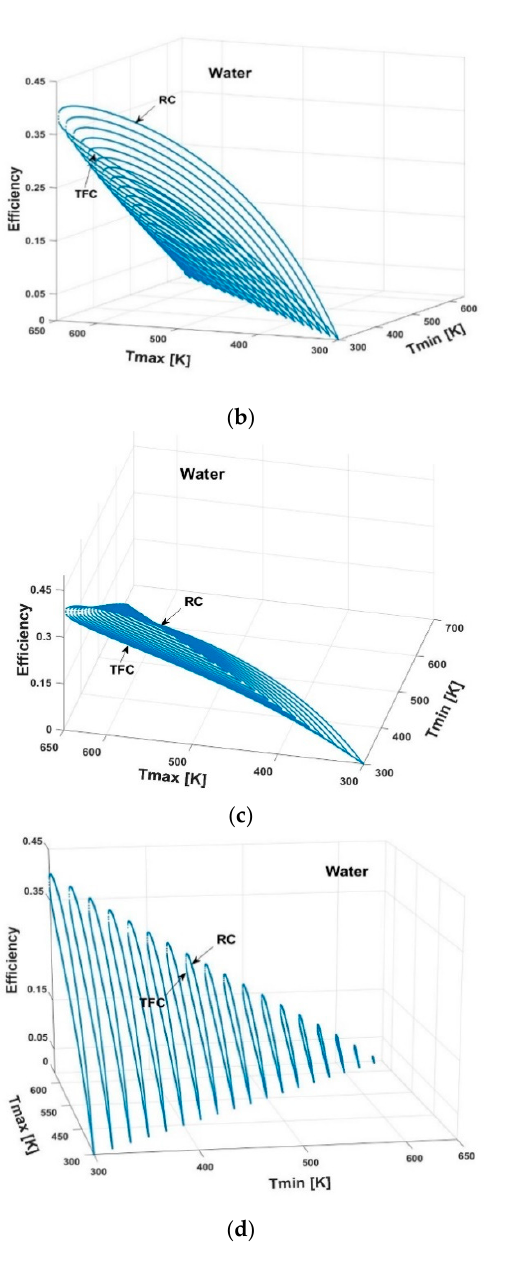
Figure 6. 3-D representation of the efficiency-curves for water ( a – d ) and butane ( e – h ). Rotating version of these figures is provided in the Supplementary Material as Figure S1a (water) and Figure S1b (butane) in animated gif-format.